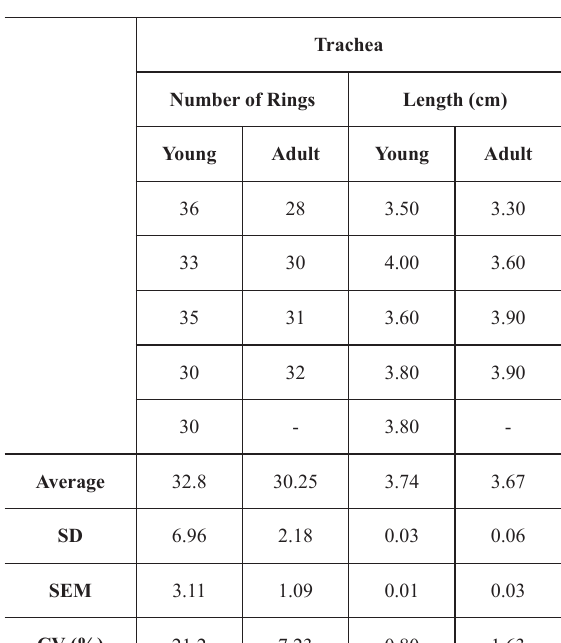
Values for number of rings and length of the trachea of Saimiri sciureus